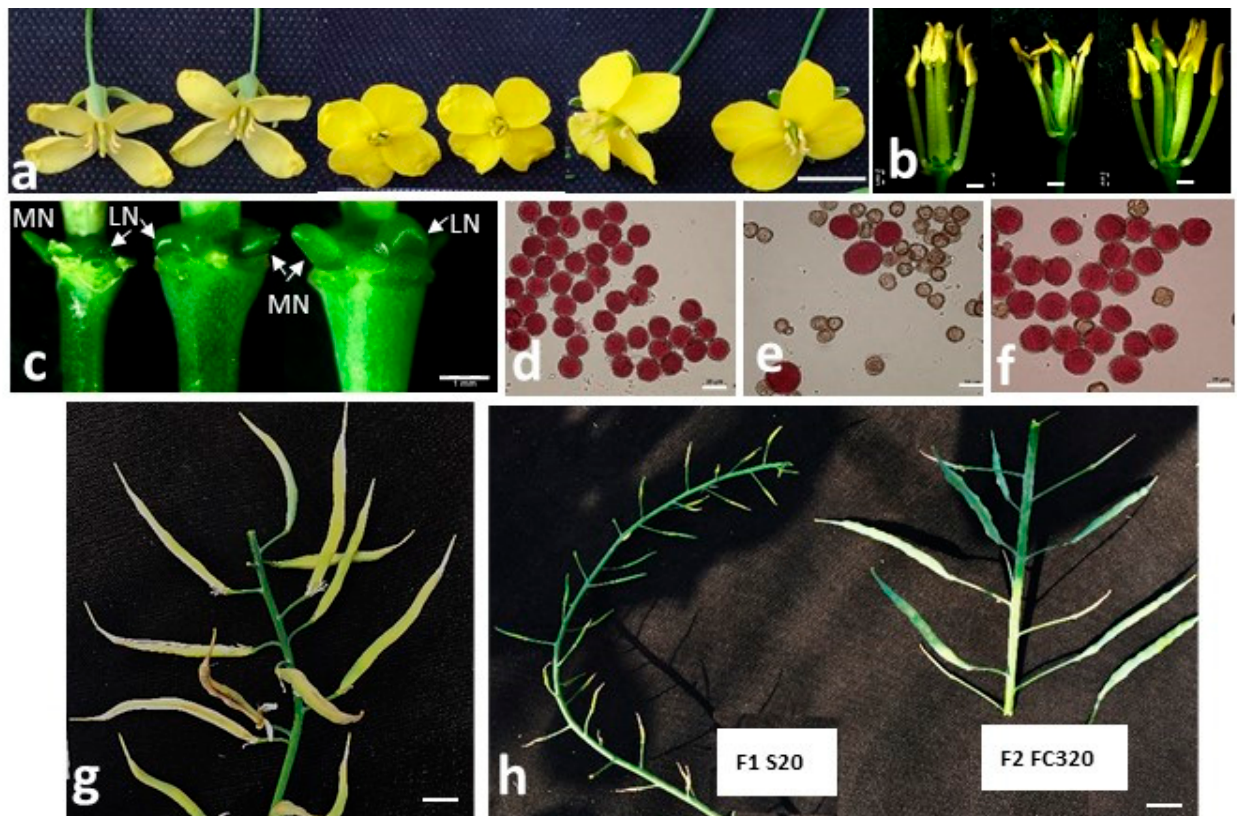
Figure 4. Phenotypic characteristics of maternal line IW1234 and the interspecific hybrids of head cabbage × rapeseed in the F 1 and F 2 generations in the generative stage. ( a ) Flowers of head cabbage IW1234 (left), S3 F 1 (head cabbage × rapeseed) (middle) and FC320 F 2 (S3 × mixture of pollen) (right, Bar = 1 cm; ( b ) Flowers with removed sepals and petals of head cabbage IW1234 (left), S3 F 1 (middle) and FC320 F 2 (right), Bar = 2 mm; ( c ) Receptacles with lateral and median nectaries, head cabbage IW1234 (left), S3 F 1 (middle) and FC320 F 2 (right), MN—median nectary, LN—lateral nectary, Bar = 1 mm; ( d – f ) Pollen staining with Alexander’s solution, Bar = 25 μ m; ( d ) IW1234; ( e ) S3 F 1 ( f ) FC320 F 2 ; ( g ) Pod of head cabbage IW1234; ( h ) Pod of S20 F 1 and FC320 F 2 generations. Scale bars represent 1cm ( g,h ).